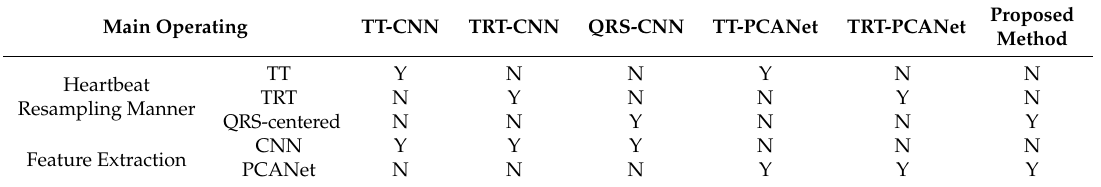
Table 3. Six Methods with different resampling strategy and feature extraction